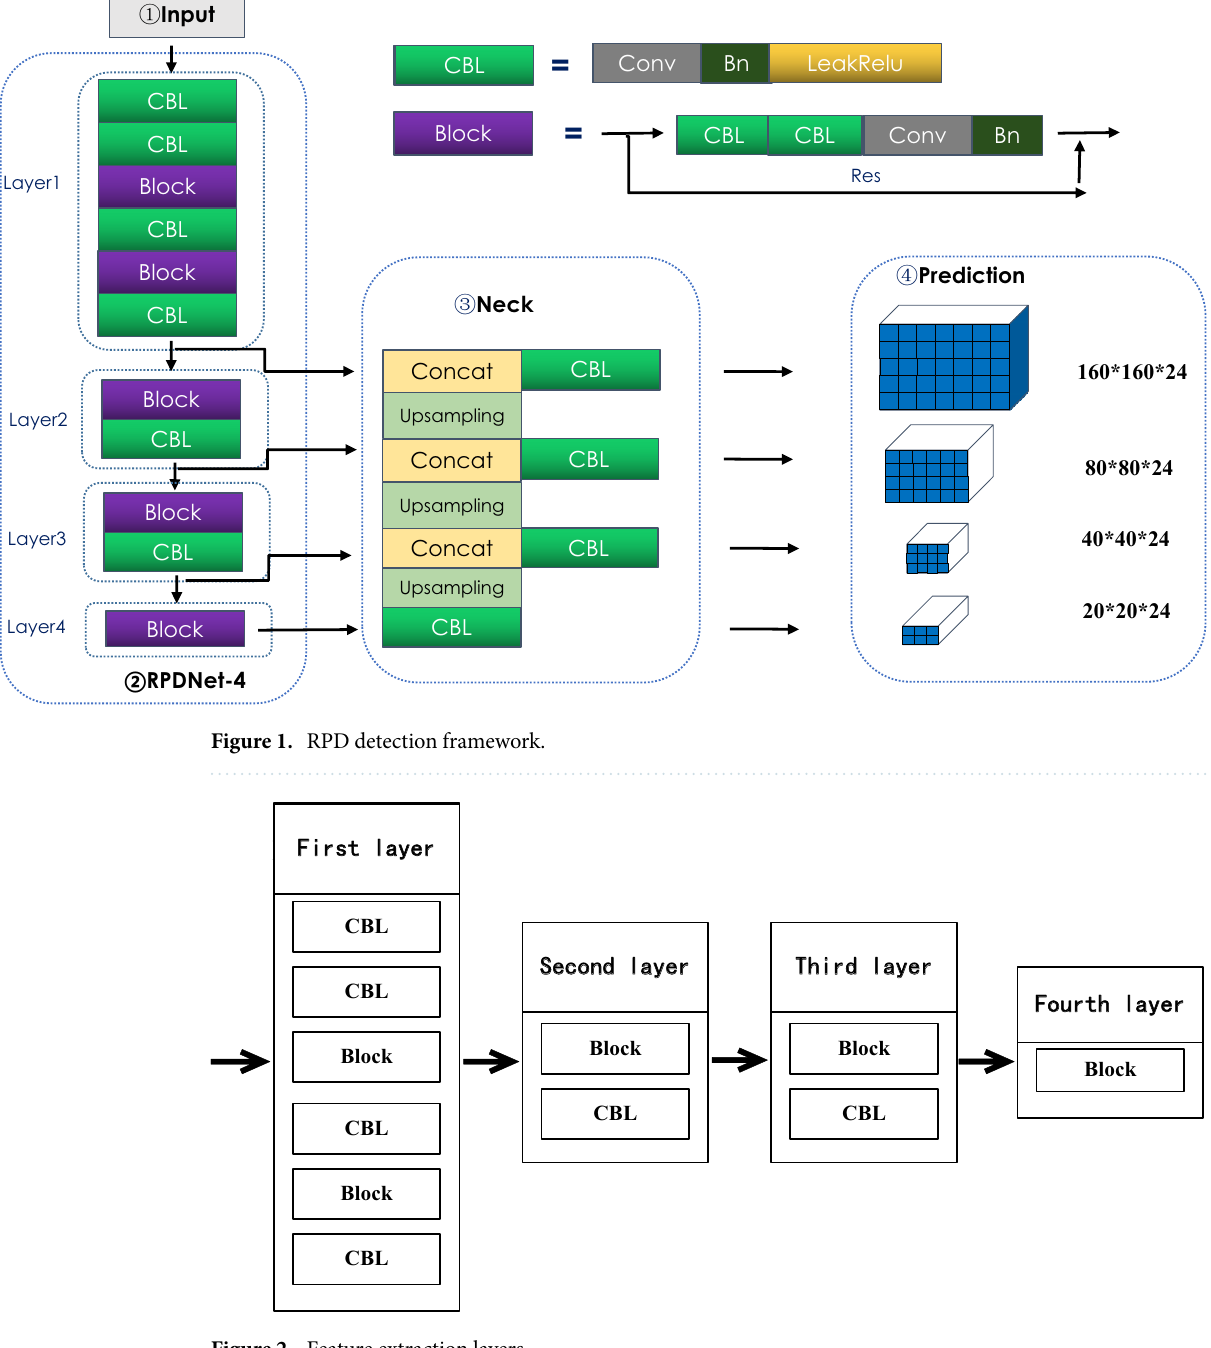
Figure 2. Feature extraction